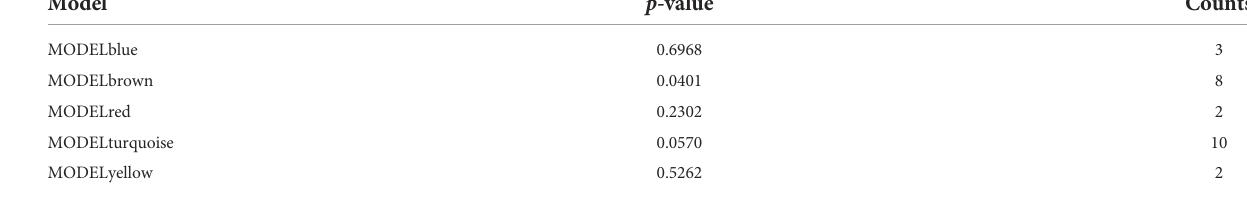
TABLE 3 Enrichment of 39 targets of 13 m6A regulators in fi ve modules. Model